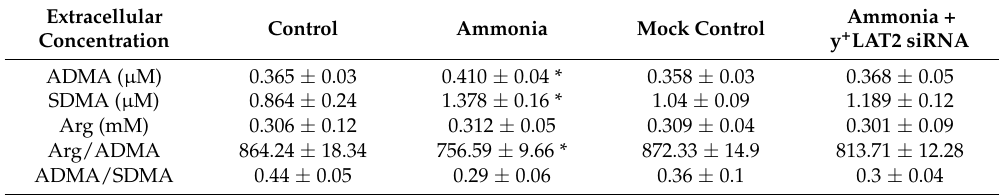
Table 2. ADMA/SDMA/Arg concentrations in cell culture medium following treatment with ammonia and effect of silencing Slc7a6 gene silencing. Results are mean ± SD; n = 4; * p < 0.05 vs. control.